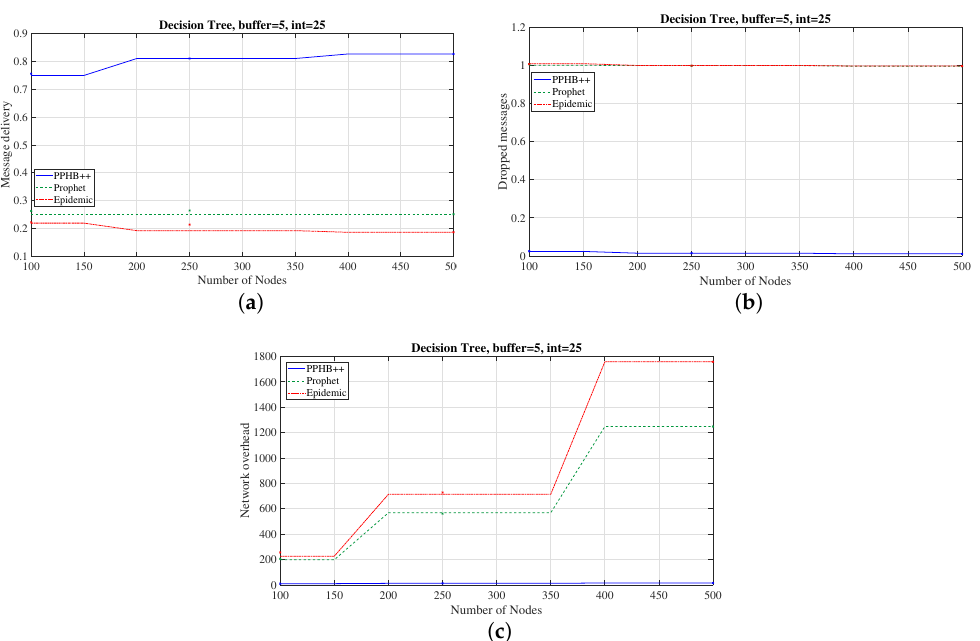
Figure 2. Decision Tree regression for PPHB++, Epidemic, and Prophet algorithms. ( a ) Messages De- livery Probability (MDP). (The y-axis parameter is normalized to a scale between 0 and 1). ( b ) Dropped Messages Probability (DMP). (The y-axis parameter is normalized to a scale between 0 and 1). ( c ) Net- work